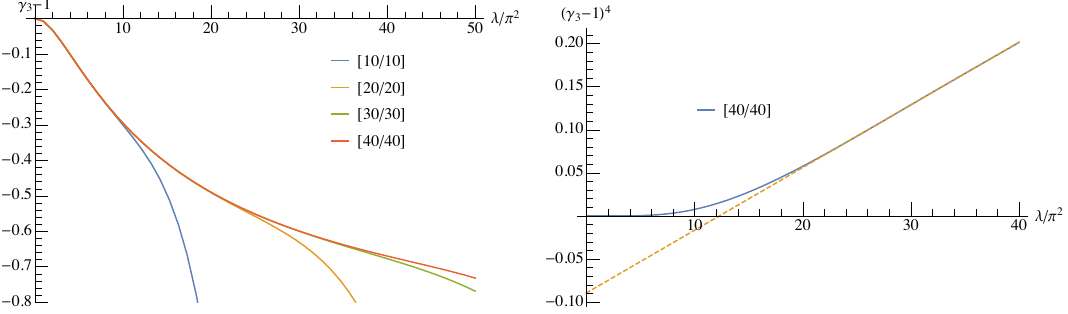
Figure 9 . (Left) Pad(cid:19)e-Borel resummation of (cid:1) (cid:13) 3 using diagonal [ M=M ] approximants with M = 10 ; 20 ; 30 ; 40. (Right) Linear (cid:12)t to ((cid:1) (cid:13) 3 ) 4 in the intermediate coupling region (cid:21)=(cid:25) 2